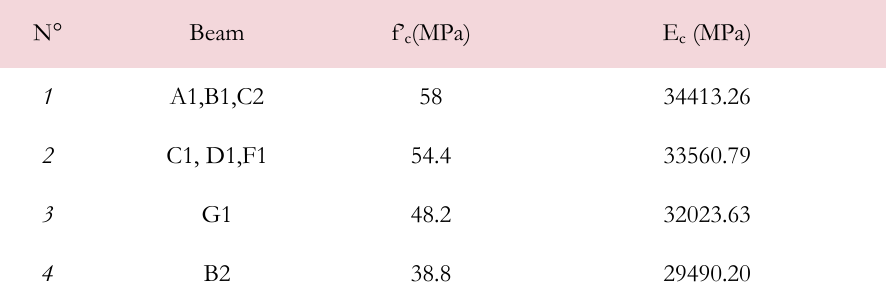
Table 3: The calculated concrete elastic modulus for each TCC